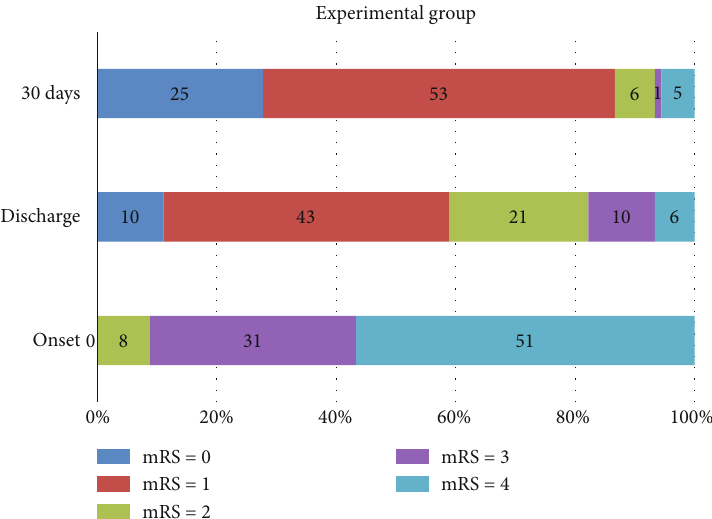
Figure 4: Modi fi ed Rankin Scale score distribution at baseline onset, discharge, and day 30 of stroke in the experimental group (DLBS1033 therapy+standard